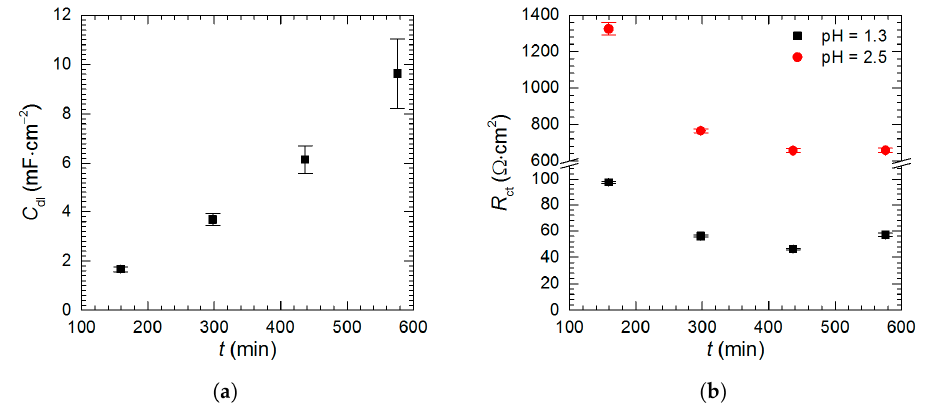
Figure 14. Kinetics of selective corrosion of intermetallic Al 2 Cu: ( a ) double-layer capacitance at pH = 1.3; ( b ) charge-transfer resistance at pH = 1.3 and = 2.5; c V = 0 mM, T = 303 K.